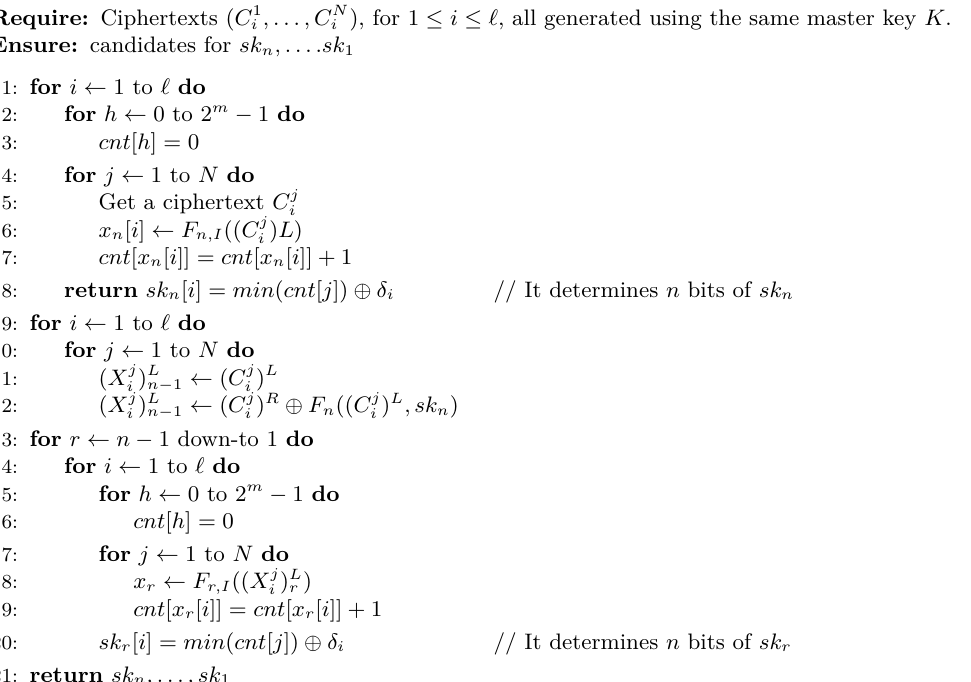
Algorithm 3 Key-recovery on a Feistel cipher with an infection-based countermeasure, assuming that δ and i are known for 1 ≤ i ≤ i